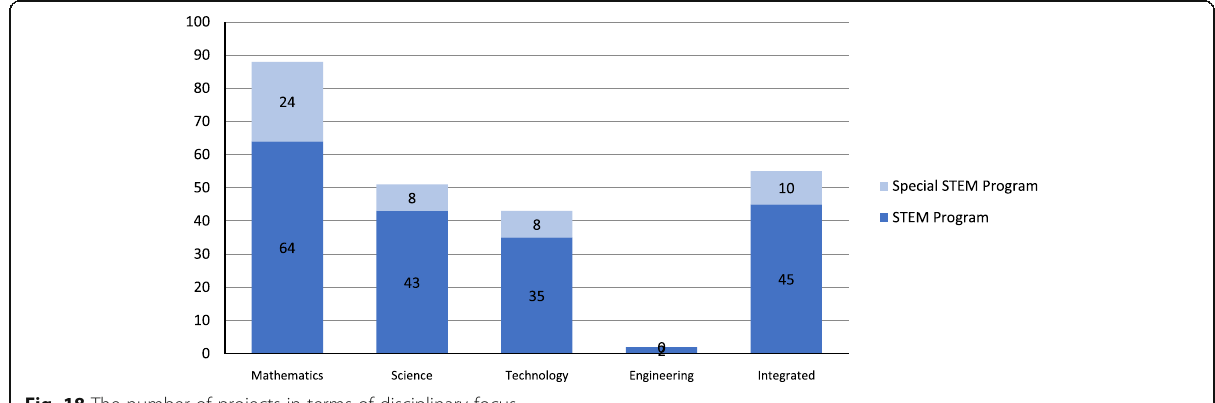
Fig. 18 The number of projects in terms of disciplinary